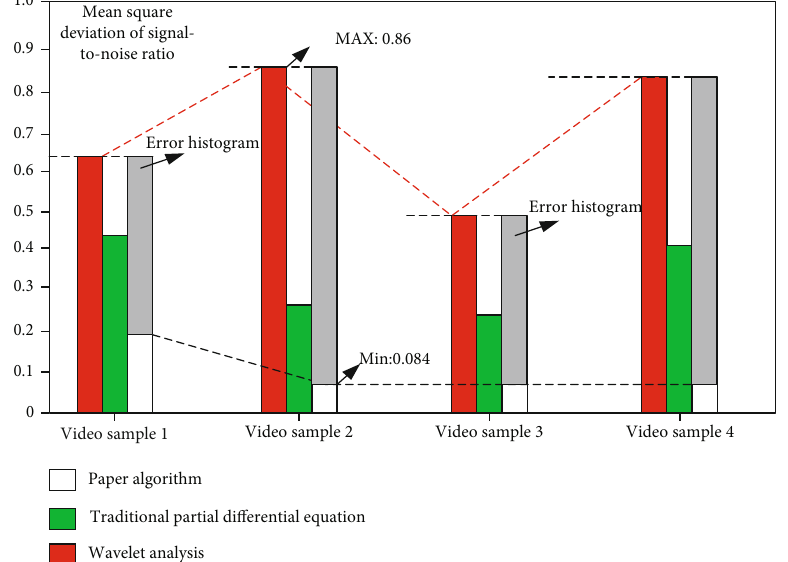
Figure 6: Experimental curves of mean square deviation of di ff erent algorithms under four groups of sample